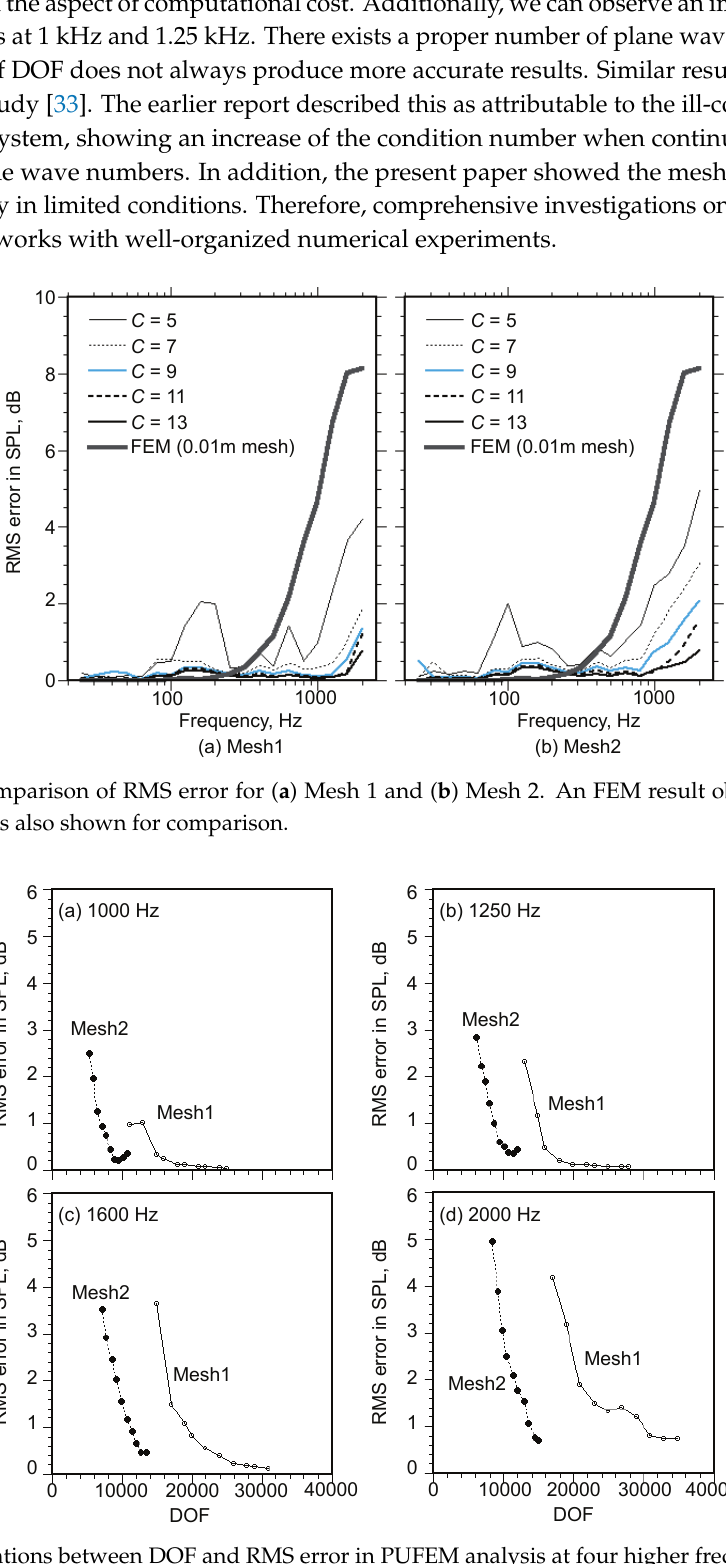
Figure 7. Relations between DOF and RMS error in PUFEM analysis at four higher frequency bands: ( a ) 1 kHz, ( b ) 1.25 kHz, ( c ) 1.6 kHz, and ( d ) 2 kHz. The DOF in the x -axis is the value at a center frequency within each